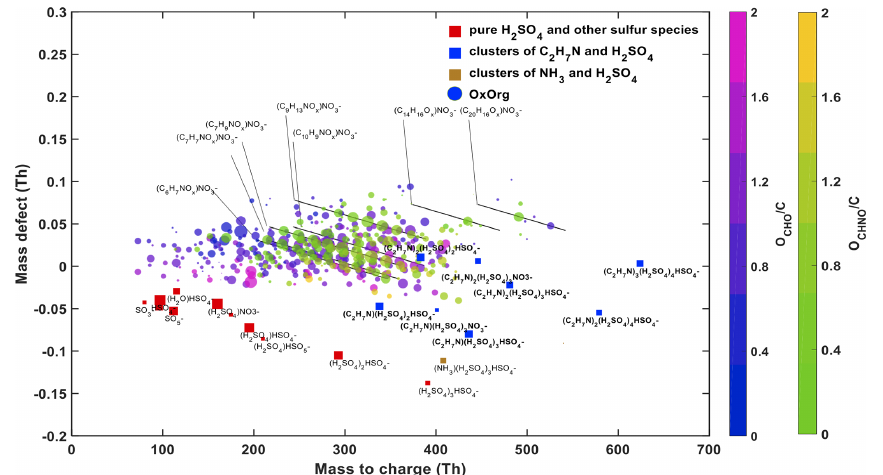
Figure 6. Mass defect plot of sulfuric acid nucleation with DMA in the presence of organics at 278K in the CLOUD chamber. The conditions are 5.2 × 10 6 cm − 3 H 2 SO 4 monomer, 4pptv DMA, 1200pptv NH 3 , 680pptv NO, 420pptv NAPH, 2200pptv TMB and 9250pptv TOL. Sulfate clusters are shown by red squares, sulfate–DMA clusters containing up to 5 sulfur molecules by blue squares, sulfate–NH 3 clusters by brown squares, and organics by circles coloured by O : C and by their chemical composition CHO or CHNO, respectively. The size of the symbols is proportional to their intensity in the mass